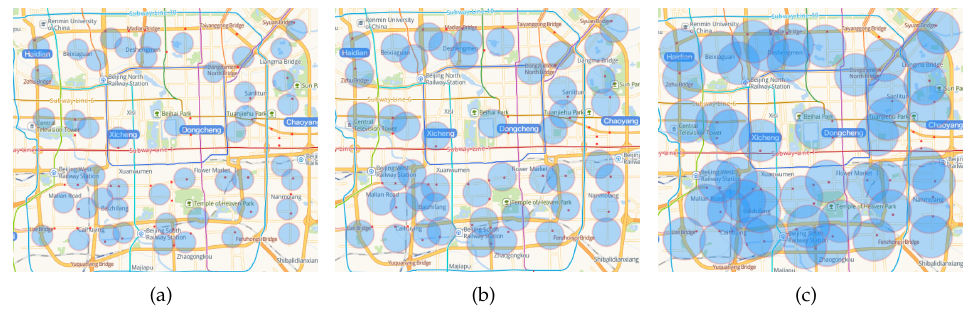
Figure 14. Varying fault-tolerant radius for predicted stations with k = 48. ( a ) fault-tolerant radius = 600 m; ( b ) fault-tolerant radius = 800 m; ( c ) fault-tolerant radius = 1200